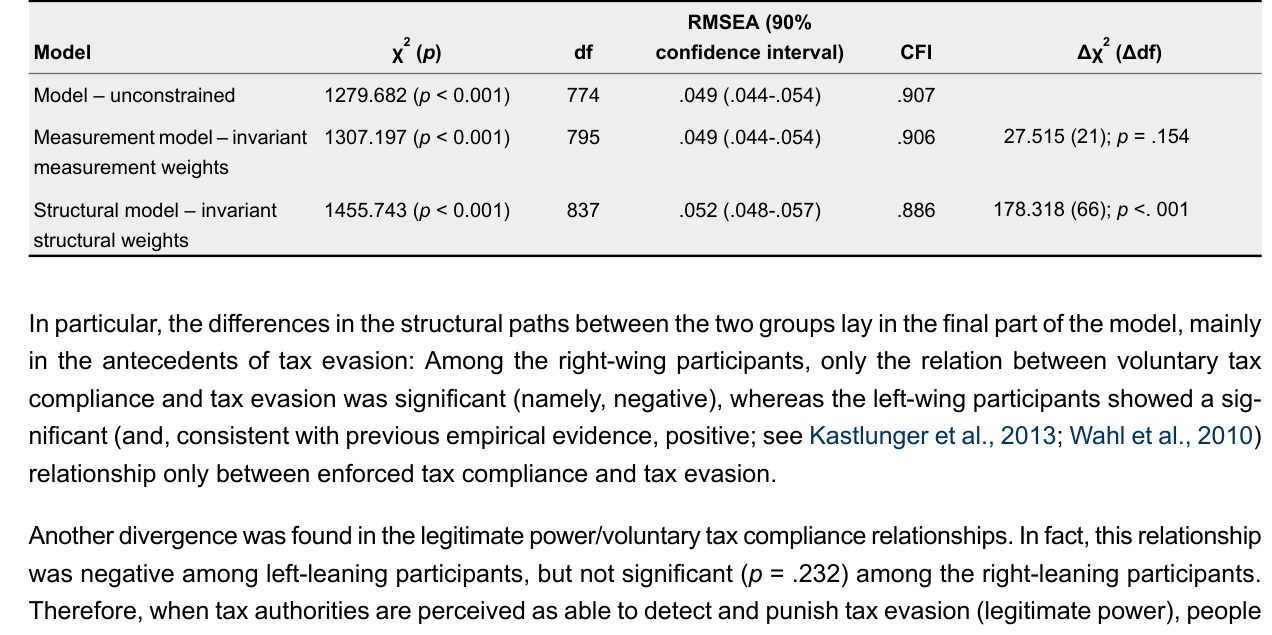
Multi-Group Structural Model Comparing Right-Wing and Left-Wing Groups of